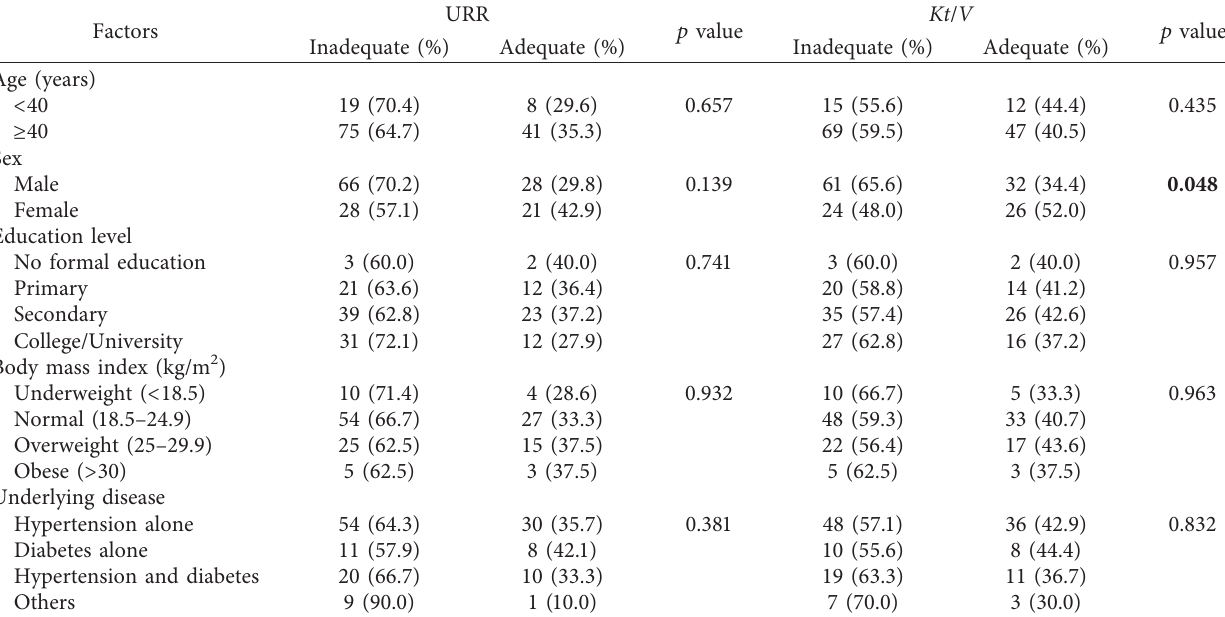
Table 2: Demographic and clinical factors associated with inadequate